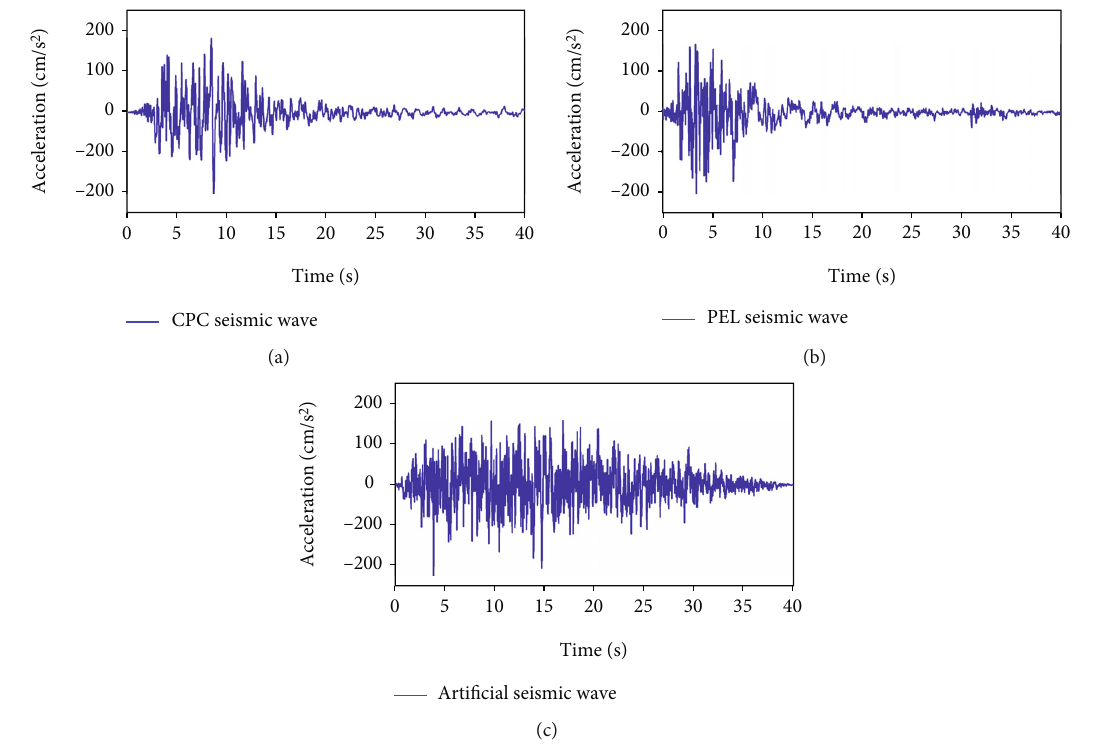
Figure 3: Time history acceleration diagram of di ff erent seismic waves.